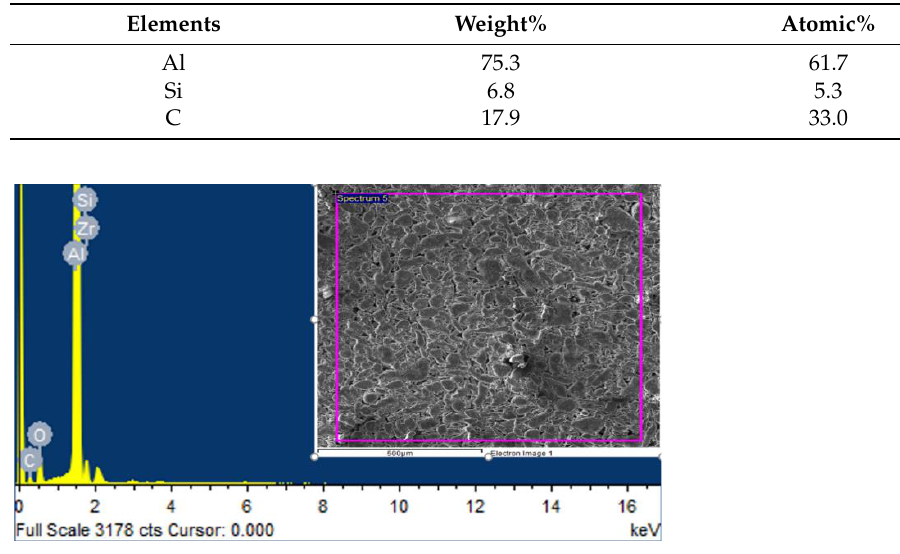
Figure 3. EDS spectrum of Al + 5%ZrSiO 4 reinforced composites. Table 5. List of elements found in the Al + 5%ZrSiO 4 reinforced composites.